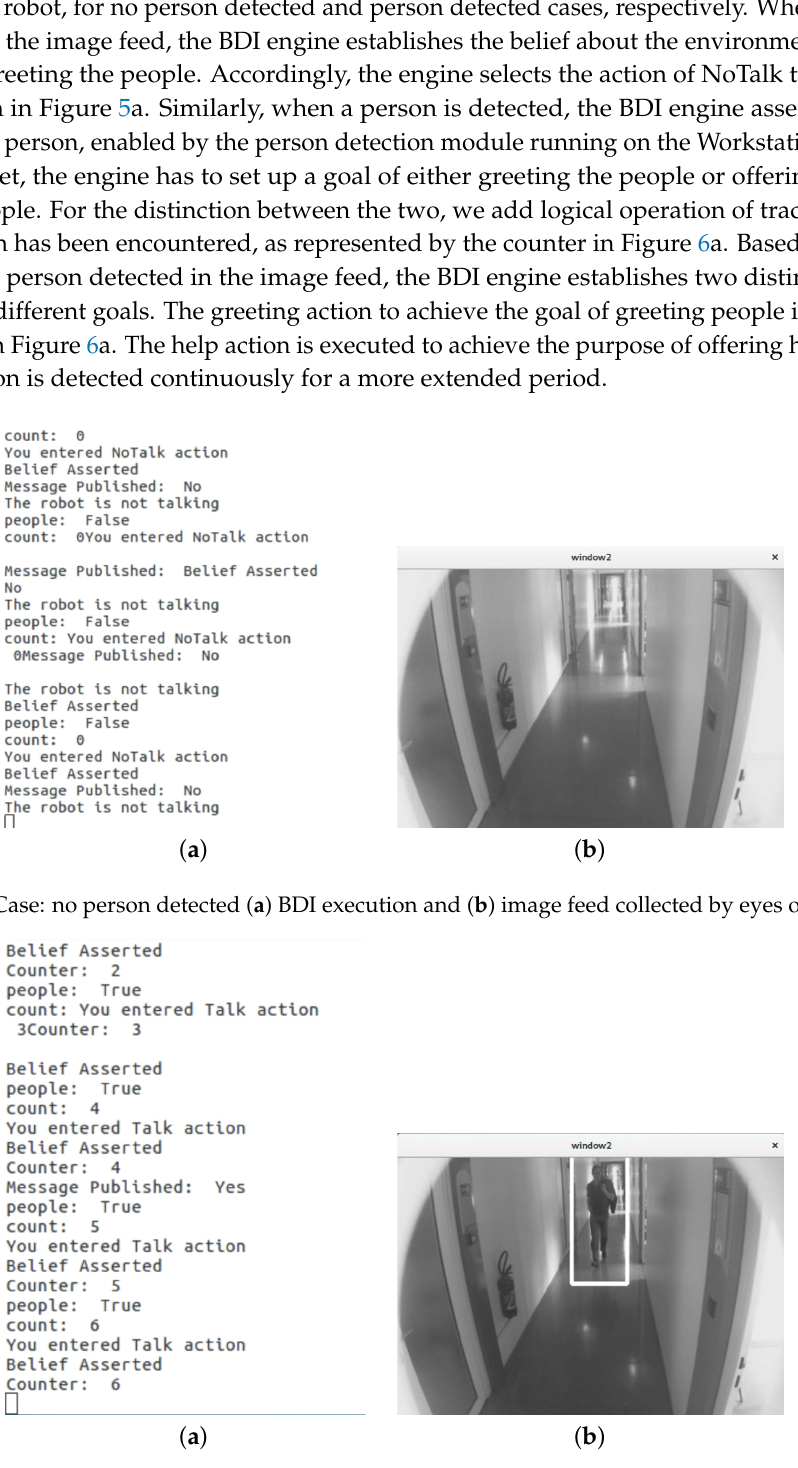
Figure 6. Case: person detected ( a ) BDI execution and ( b ) image feed collected by eyes of